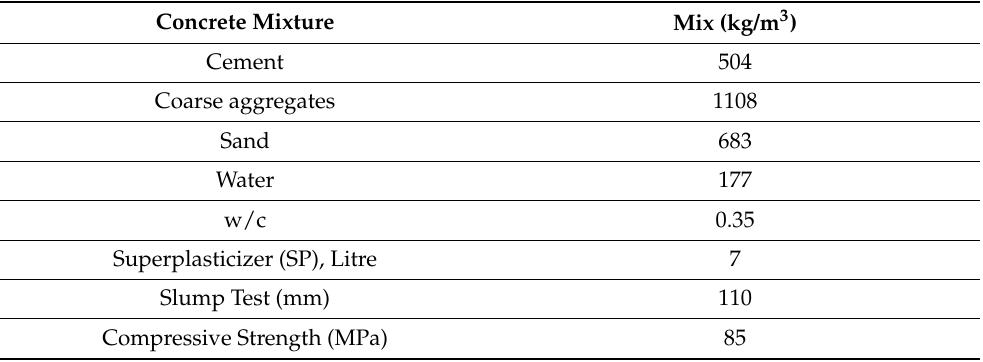
Table 2. The mixed proportions of plain